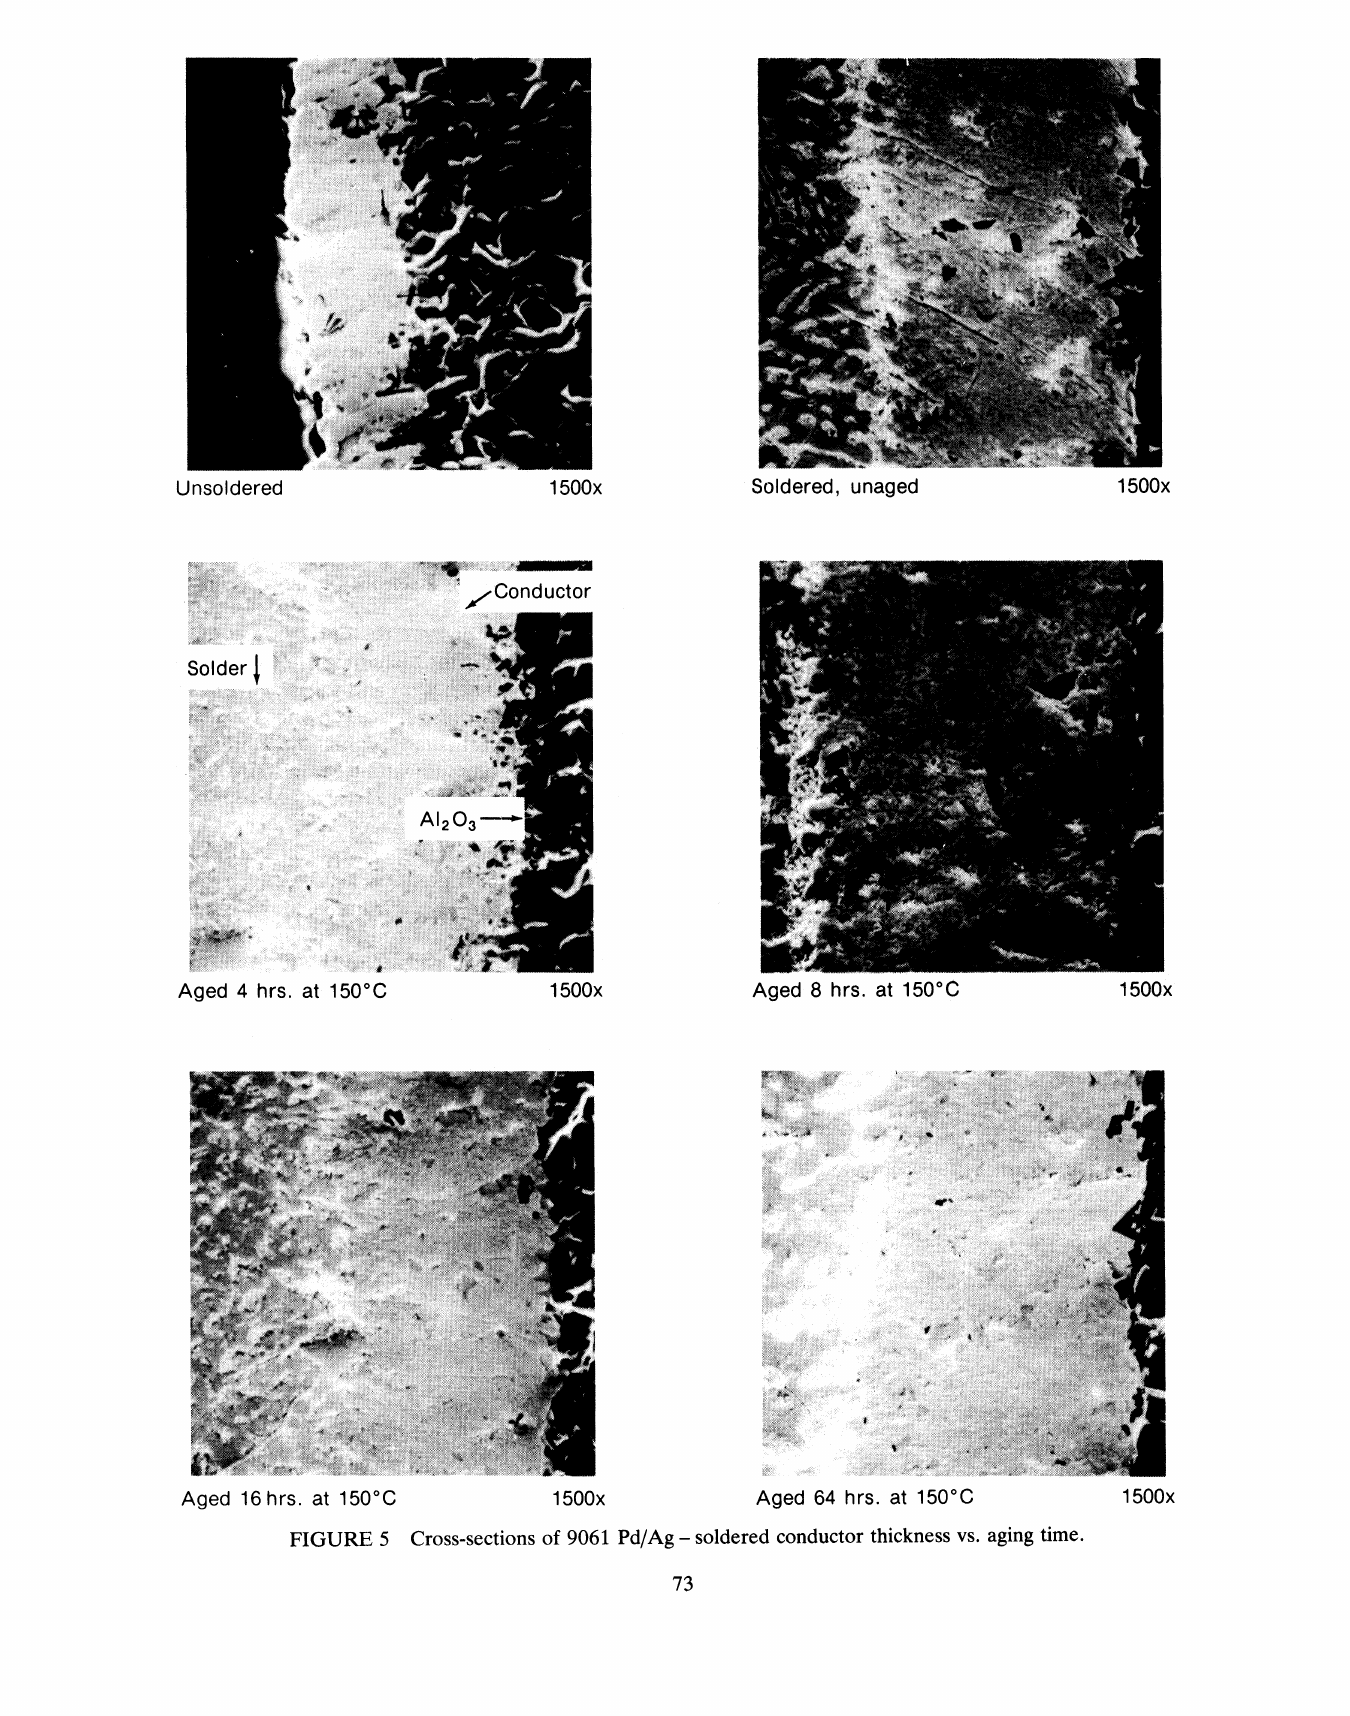
FIGURE 5 Cross-sections of 9061 Pd/Ag- soldered conductor thickness vs. aging